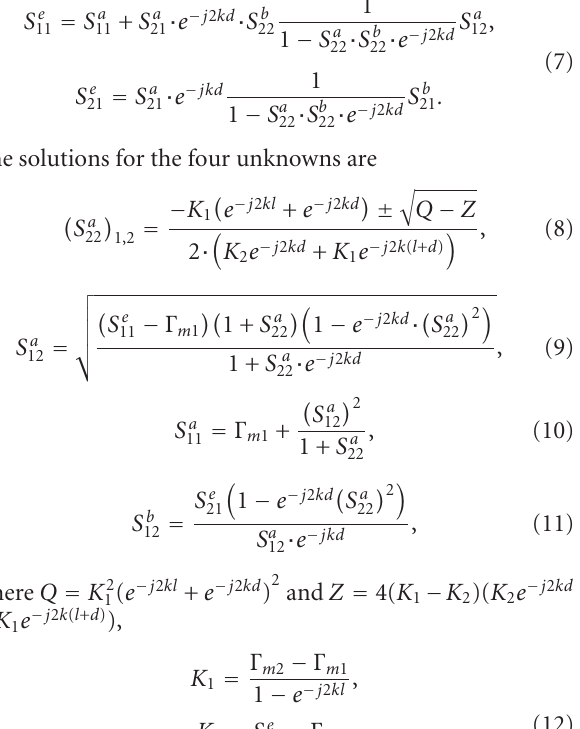
Figure 12: Measurement error